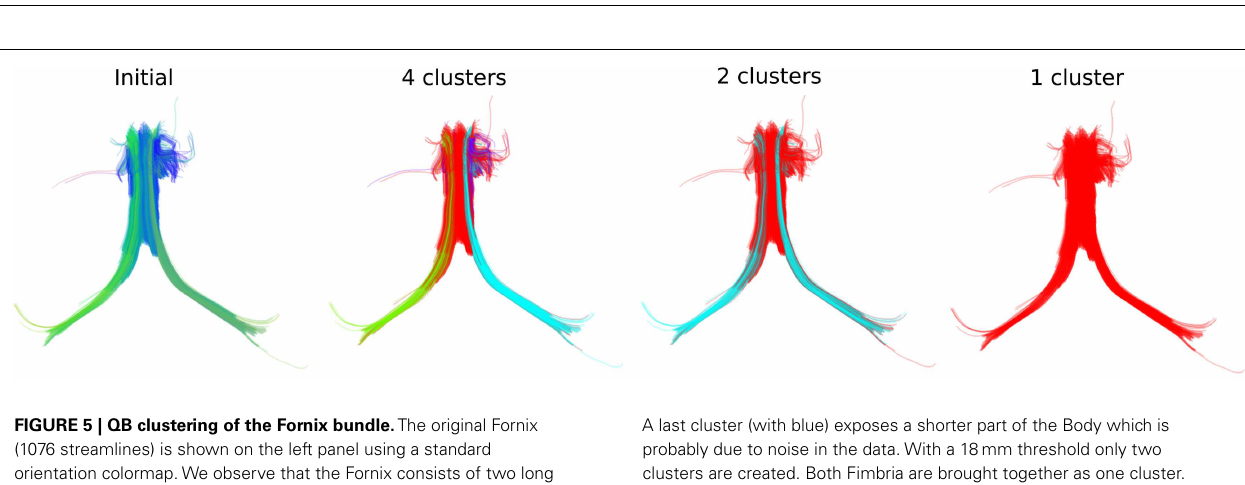
FIGURE 4 | Left: 3 bundles of simulated trajectories; red, blue, and green consisting of 150 streamlines each. All 450 streamlines are clustered together using QB. Middle and Right: centroid streamlines using thresholds 1 and 8, respectively. At low threshold the underlying